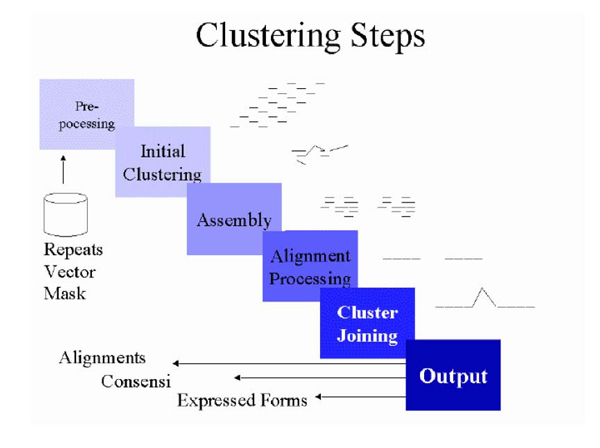
Basic EST clustering steps.